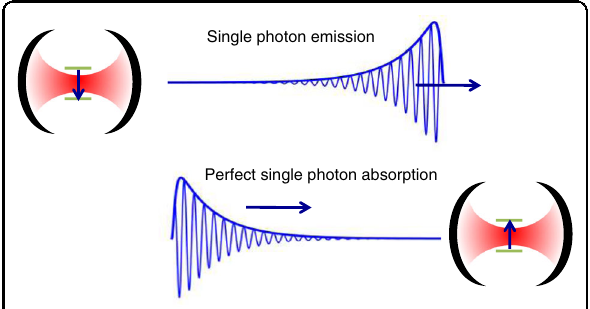
Fig. 6 Sketch of ideal single-photon emission and absorption processes. (Top) An atom placed inside a static single-mode cavity emits a single photon with asymetric temporal envelope. (Bottom) Perfect single photon absorption by the atom in the cavity requires the single photon to possess a reversed temporal